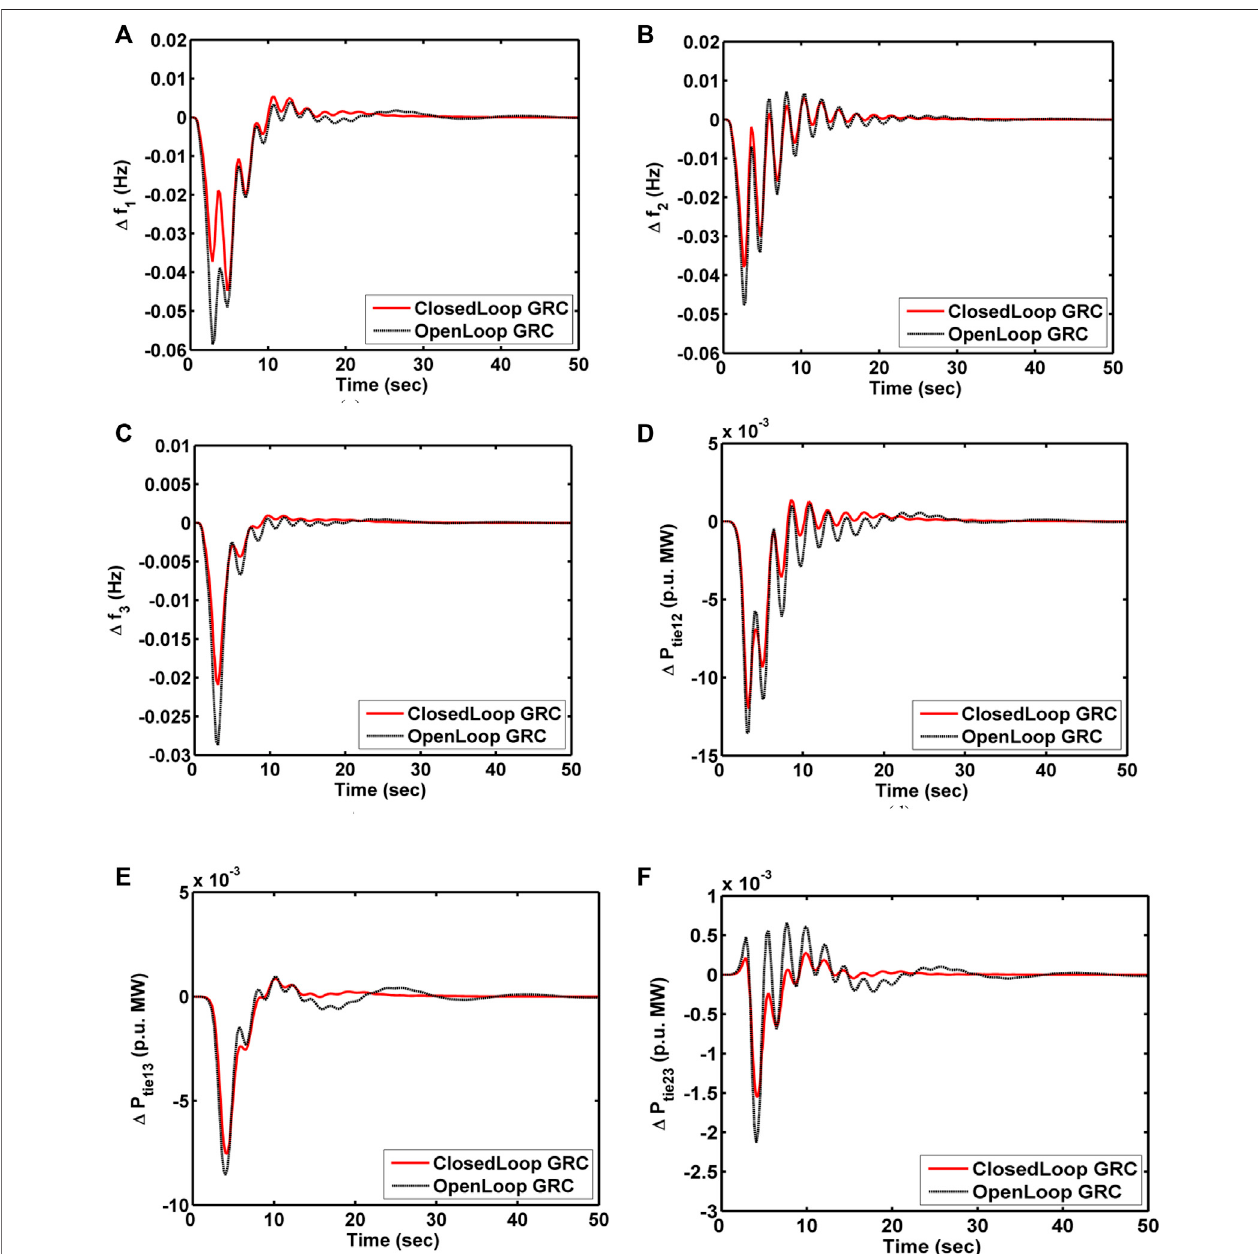
FIGURE 9 | Case 2 responses. (A) Δ f 1 , (B) Δ f 2 , (C) Δ f 3 , (D) Δ P tie12 , (E) Δ P tie13 , and (F) Δ P tie23